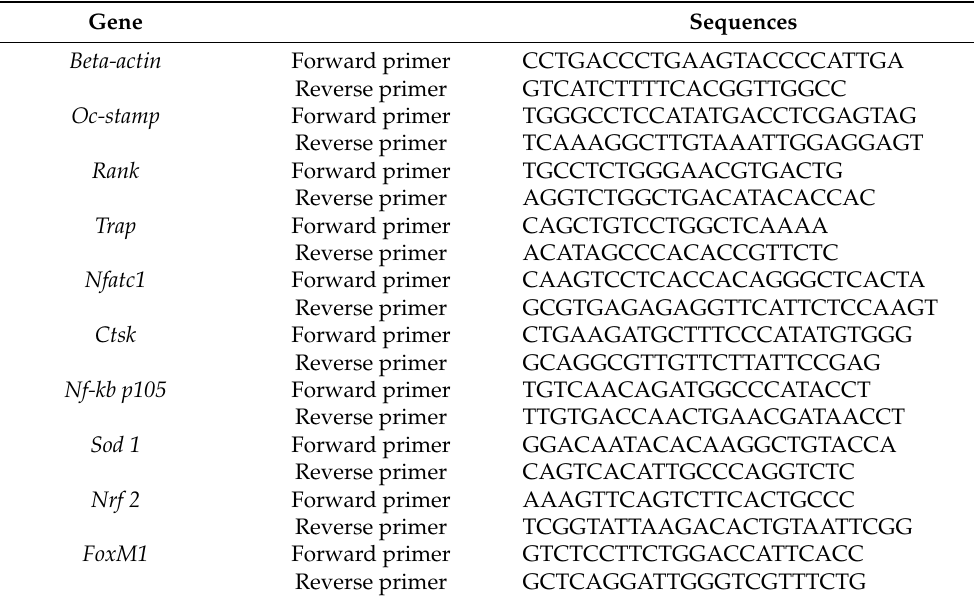
Table 1. Primer sequences. All sequences in 5 (cid:48) –3 (cid:48)